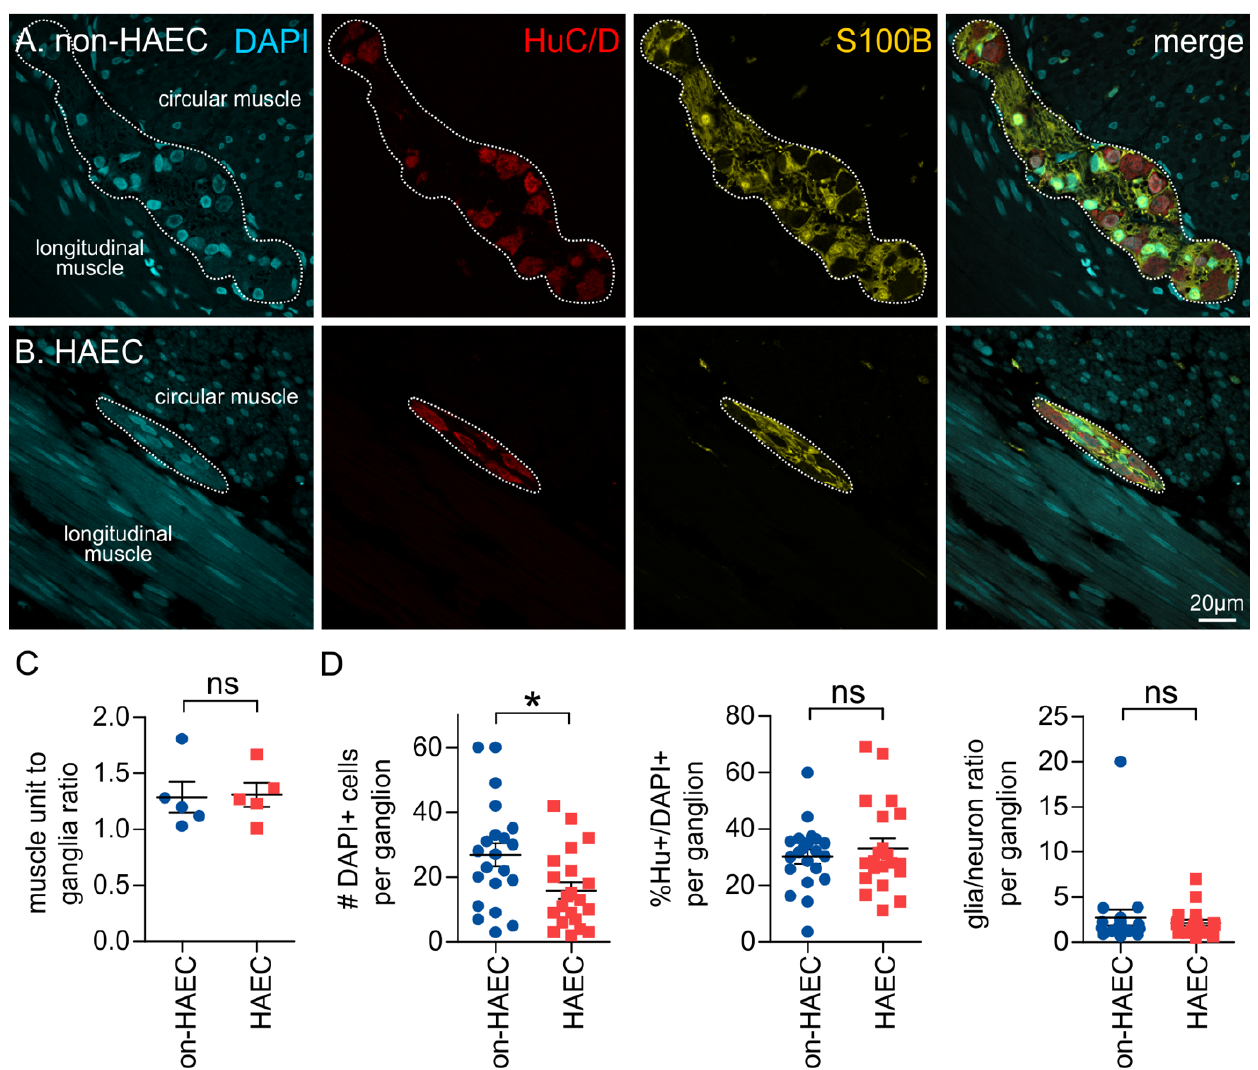
Figure 4. Comparison of ganglia from the proximal normoganglionic tissue in non-HAEC and HAEC patients. ( A , B ) Representative images of ganglia from the patient groups, with immunohistochemistry performed against DAPI, HuC/D and S100B. Note: ( C ) Quantification of the muscle unit to ganglia ratio (ns: p > 0.05, Students’ t -test). ( D ) Quantification of the size of ganglia (#DAPI+ cells/ganglion, left ), the proportion of neurons per ganglion (%Hu + /DAPI+, middle ), and the ratio of glia/neurons per ganglion ( right ). non-HAEC: n = 21 ganglia, N = 4 patients; HAEC: n = 21 ganglia, N = 3 patients. * p = 0.0158, ns: p > 0.05, Students’ t -test.